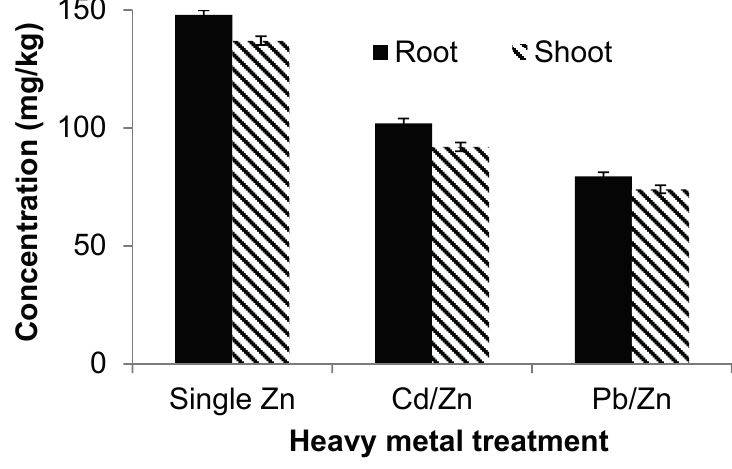
Figure 5. Comparison of zinc (Zn) uptake subject to different